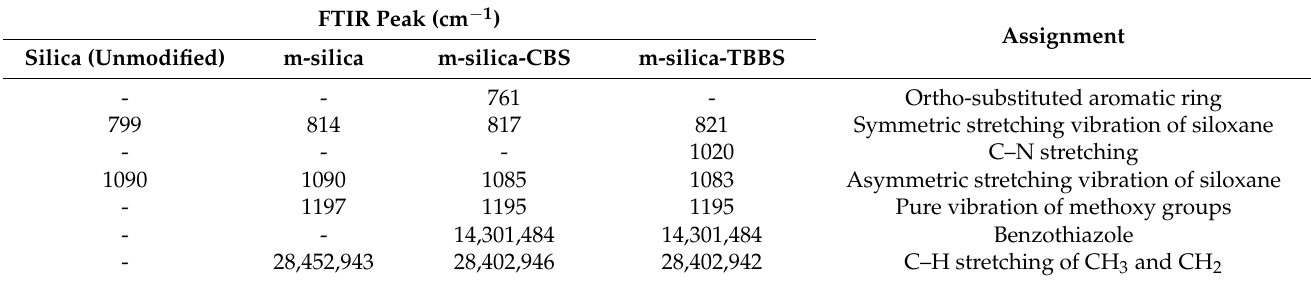
Table 2. FTIR peak assignments of silica (unmodified), m-silica, m-silica-CBS, and m-silica-TBBS.